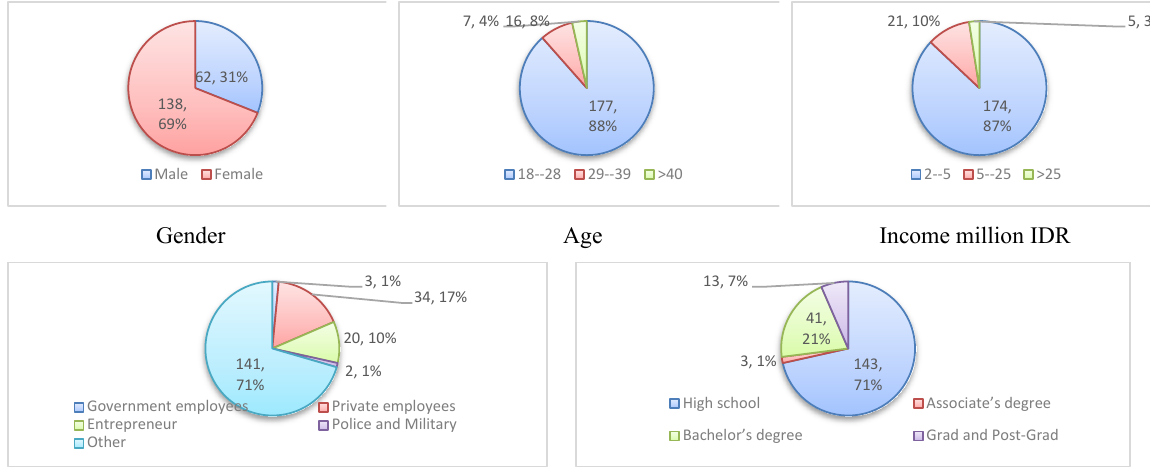
Fig. 2. Characteristics of